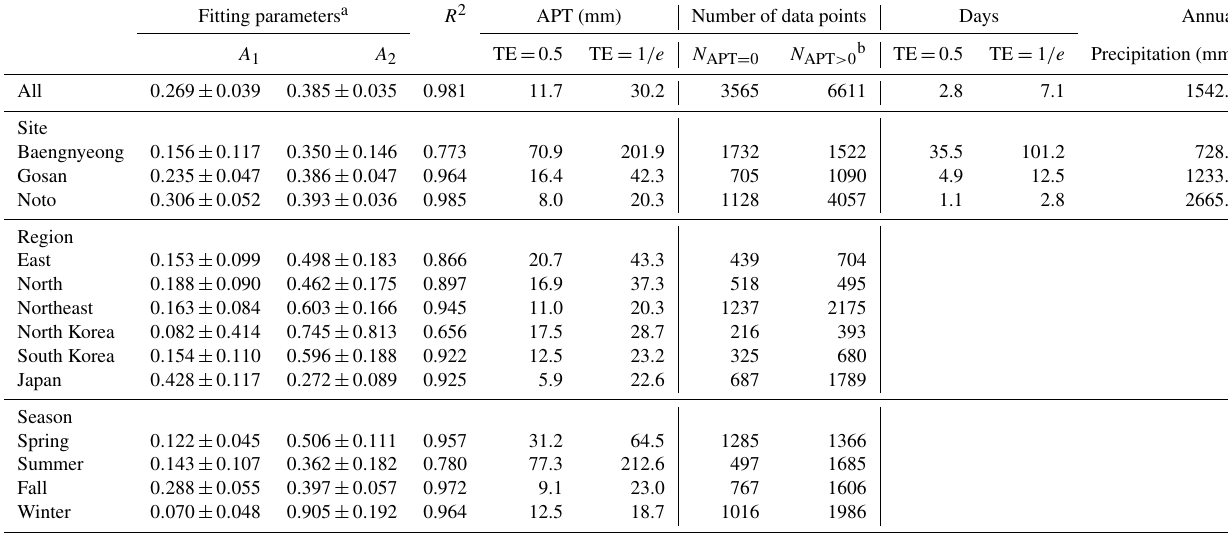
Table 1. Summary of the relationship between transport efficiency (TE) and accumulated precipitation along trajectory (APT) in Figs. 2 and 4.